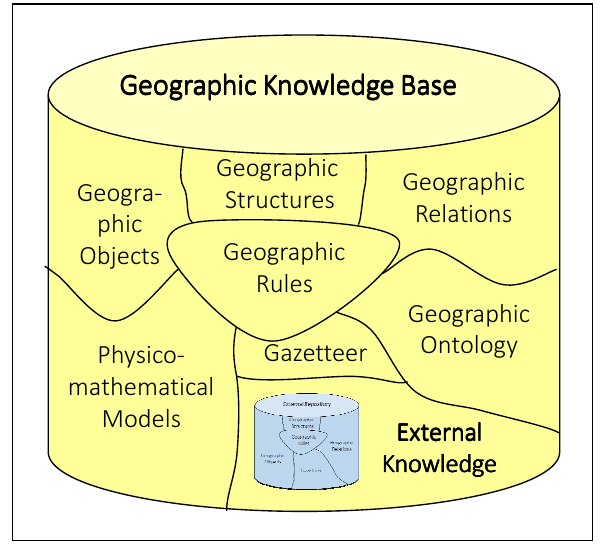
Figure 10. Architecture of a Geographic Knowledge Base with an additional repository for storing external